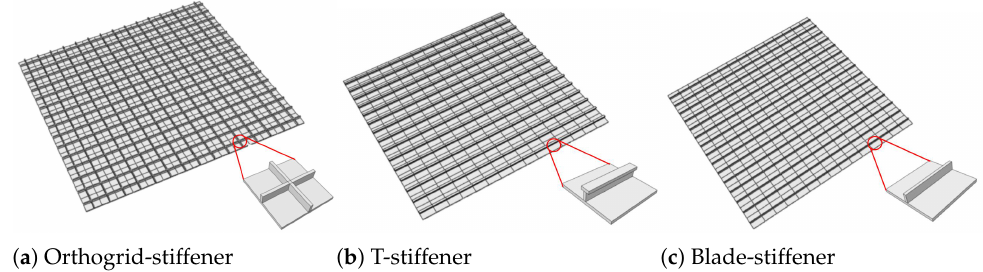
Figure 17. 3D finite element model and its unit cell of stiffened FRP panels with different stiffening